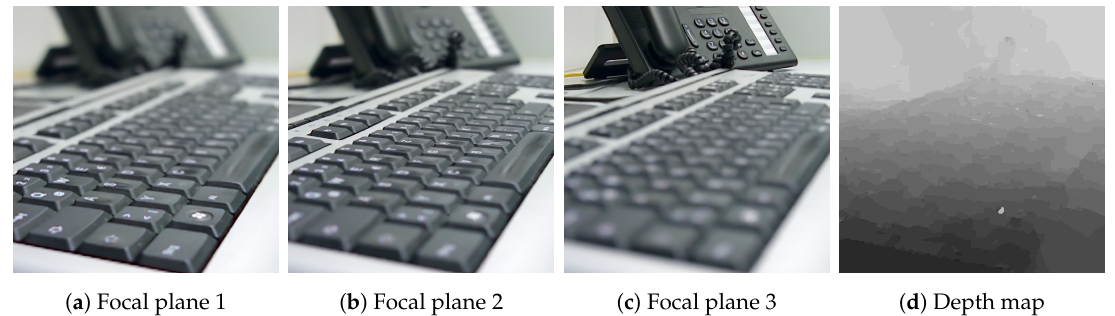
Figure 6. Based on one single image (1080 × 1080 pixel) taken by the Lytro LF light-field camera, it is possible to change the focal point within the light-field image file. In addition, the camera provides a 328 × 328 pixel depth map of the image. ( a ) Shows a close range focal point; ( b ) Shows a mid range focal point and ( c ) a focal point set to a larger distance of the same image file; ( d ) Represents the corresponding depth map of the light-field